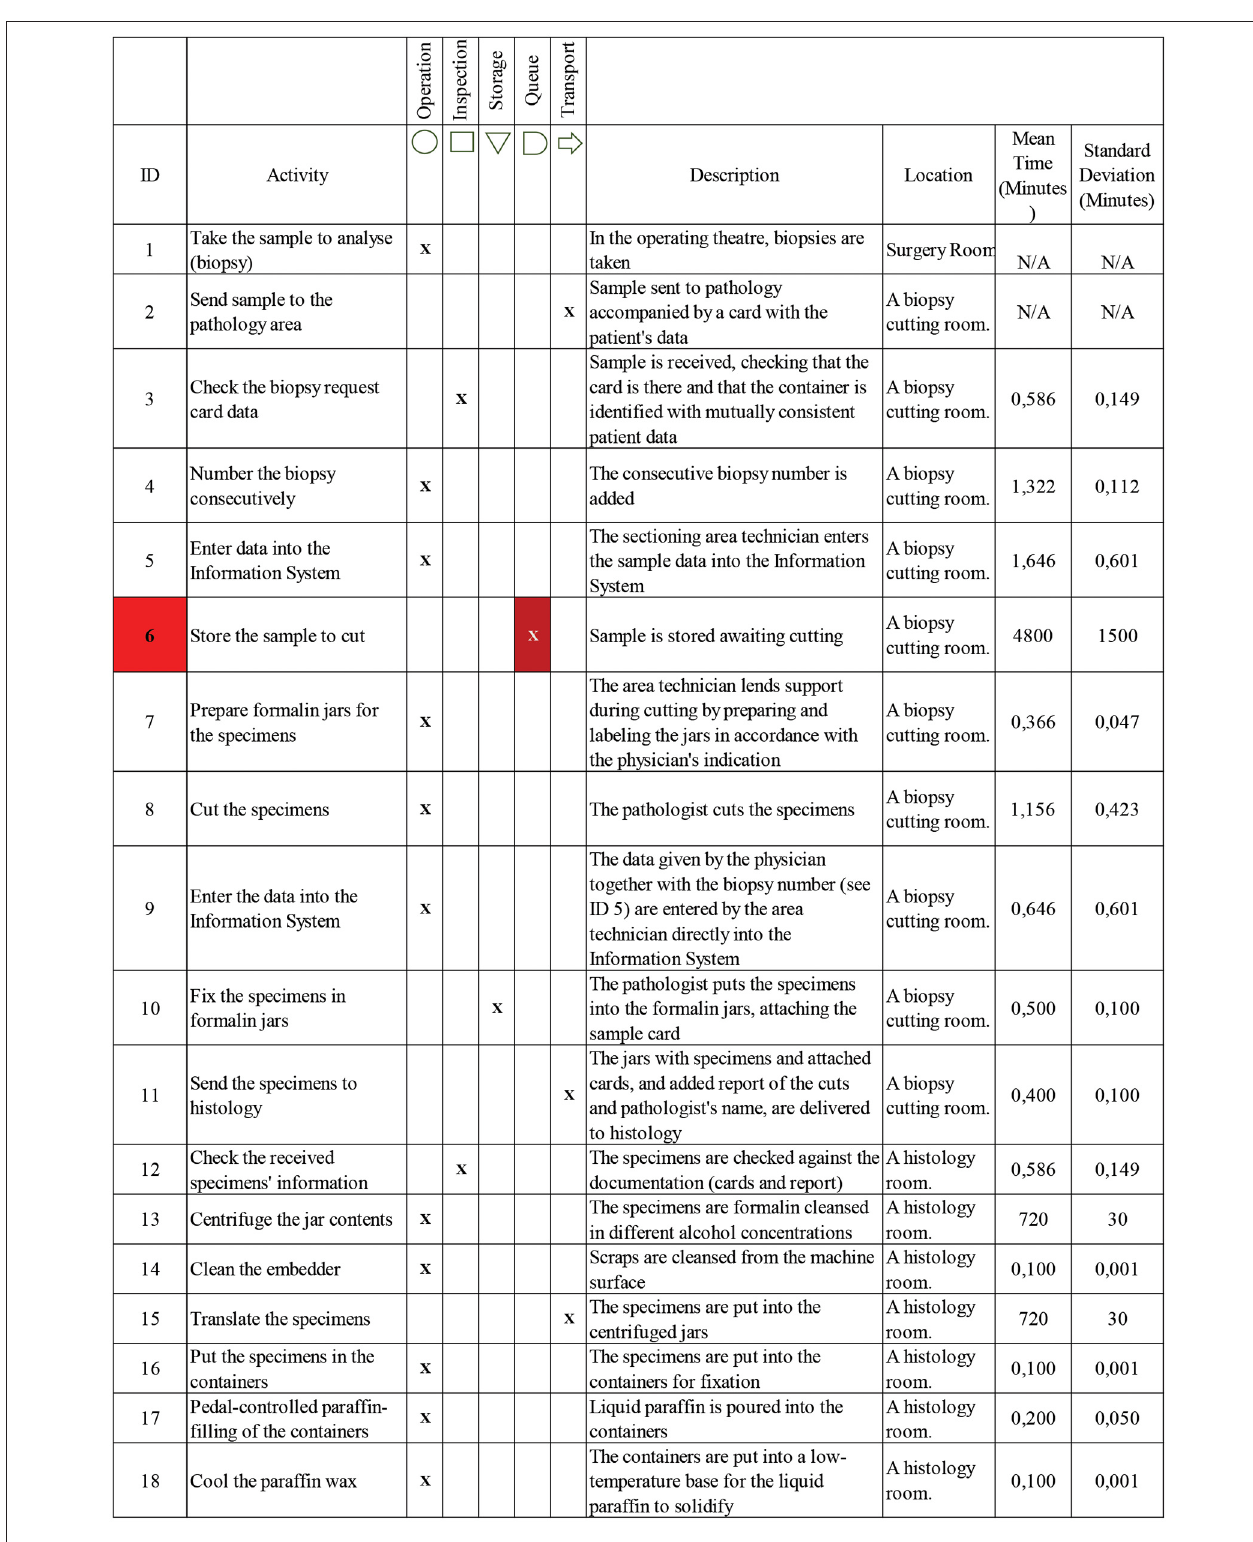
FIGURE 2 | Flowchart of the biopsy